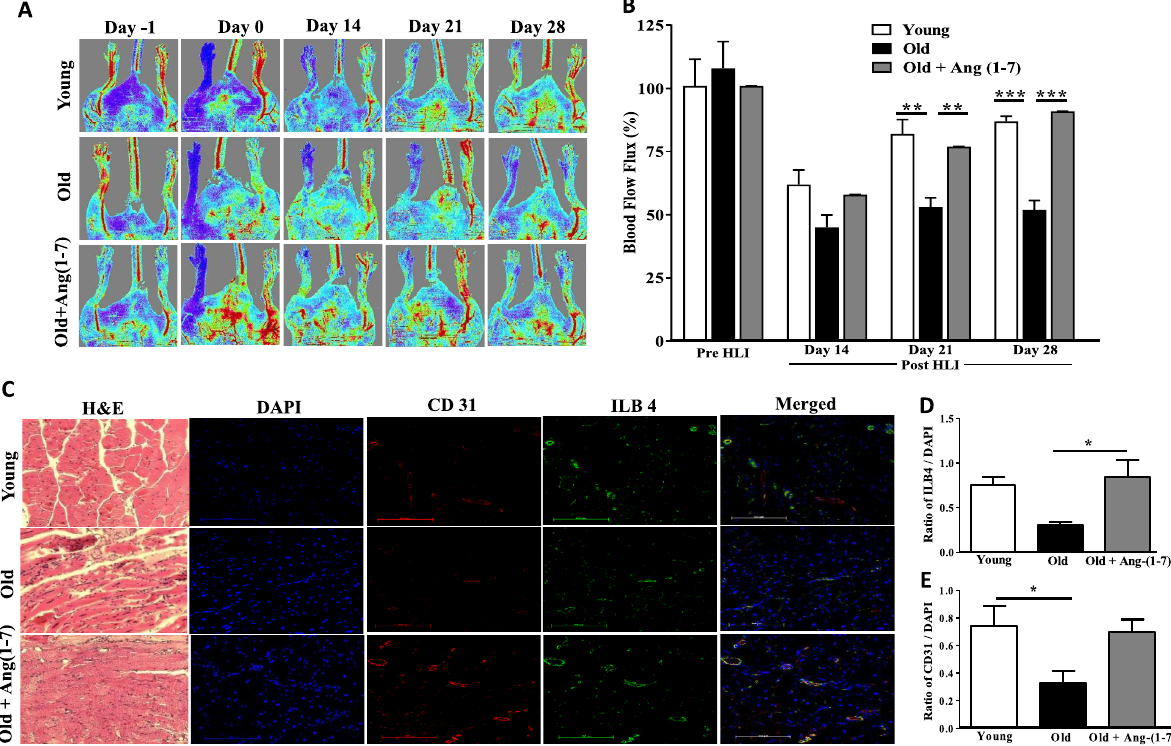
Figure 4. Blood flow recovery and vascularization in the areas of ischemia were lower in the Old that was restored by Ang-(1–7): ( A ) Shown were representative pseudo-color images of blood flow obtained by Laser Doppler imaging in different treatment groups before (day -1) and at day-0, day-14 and day-28 after HLI. ( B ) Blood flow recovery was lower in the Old group compared to the Young on day-21 an day-28, which was restored by Ang-(1–7) treatment. P < 0.01 and ***P < 0.001, n = 6. Two-way ANOVA with Bonferroni detected significant differences among treatment groups (P < 0.0001). Bonferroni post-test was used to perform multiple comparisons. ( C ) Shown were representative bright field images of Hematoxylin and Eosin (H&E) staining and fluorescence images with CD31 and isolectin-B4 (IlB4) staining of gastrocnemius muscle sections. ( D , E ) Intensity of capillary density with CD31 or IlB4-positivity was quantified by using ImageJ software. Capillary density determined by either CD31 or IlB4 was lower in the ischemic areas derived from Old mice compared to the Young, which was increased by Ang-(1–7) treatment. *P < 0.05, One-way ANOVA with Tukey’s post-test for multiple comparisons (n =